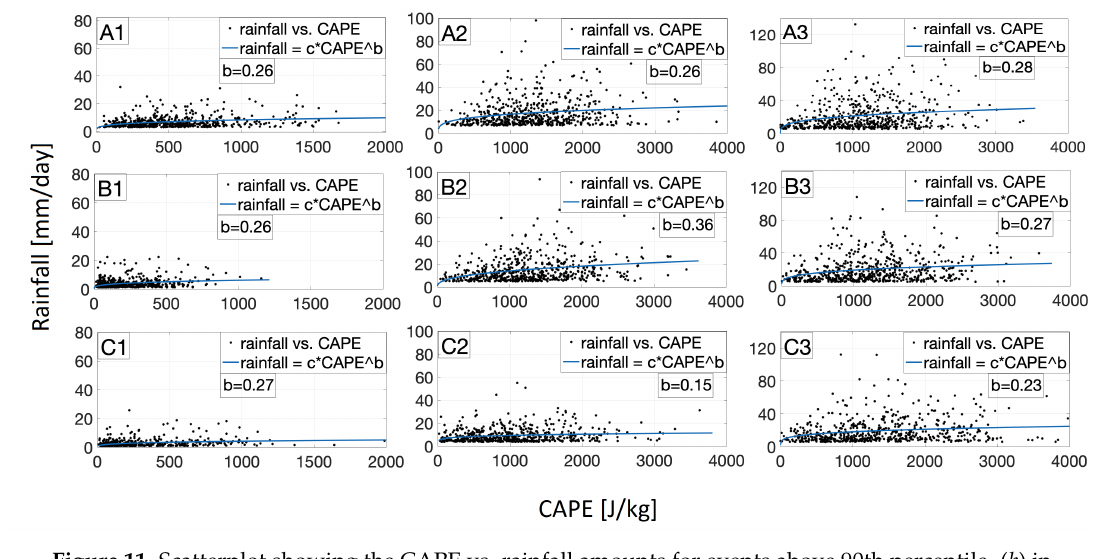
Figure 11. Scatterplot showing the CAPE vs. rainfall amounts for events above 90th percentile. ( b ) in regression equation ( rainf all = c ∗ CAPE b ) shows the regression coefficient for the independent variable CAPE for all boxes along the climatic and topographic gradients. See Figure 4A for all boxes (A1–C3). Regression coefficient ( b ) reveals a value around parcel theory (0.5) in all boxes. The linear model defined in Equation (4) also indicates exponential sensitivity of rainfall to dew-point temperature and a power-law relationship between rainfall and CAPE [20]. We used the linear multivariable regression model (Equation (4)) [20] to show the joint effect of both climatic variables in our study region. The regression analysis reveals statistically significant relationships ( p -value << 0.001) between the dew-point temperature and CAPE and 90th percentile rainfall over all nine areas. The regression coefficient ( α ) for the dew-point temperature in (Equation (4)) is higher and it is close to CC relationship (0.068 ◦ C − 1 ) for the extreme (90th percentile) rainfall in the tropical region and over intermediate-elevation (Box A2) and low-elevation foreland areas (Box A3) (Figure